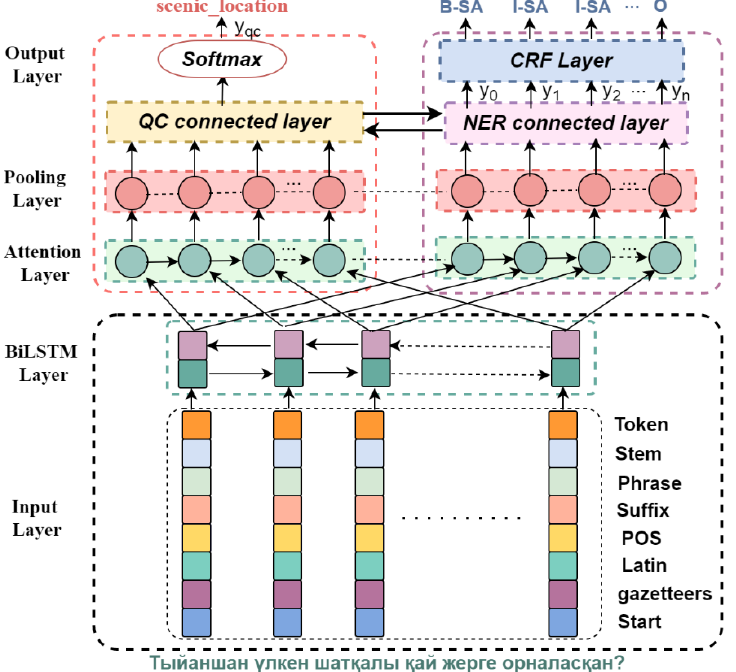
Figure 1. Illustration of the architecture of the MTQU model. (Kazakh can be written using both right-to-left (Arabic) and left-to-right (Latin or Cyrillic) scripts, and this work uses Cyrillic scripts).